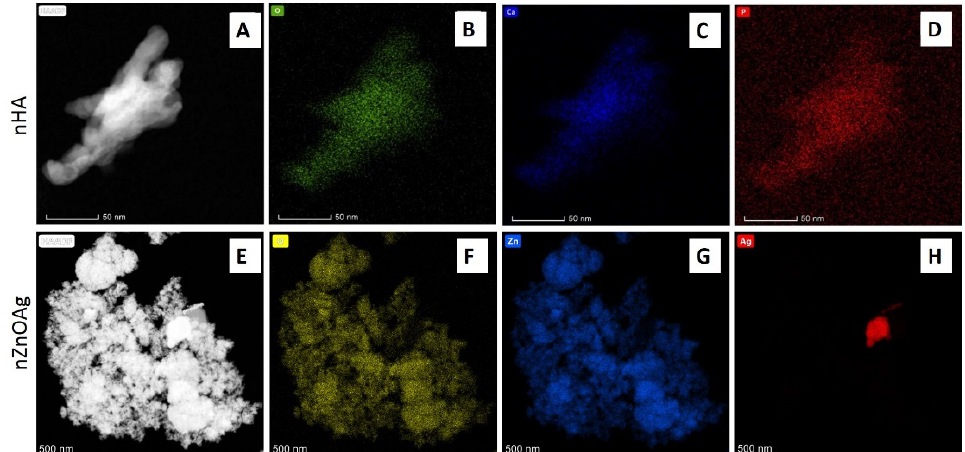
Figure 3. TEM images with energy ‐ dispersive X ‐ ray (EDX) mapping of different elements for nHA ( A – D ) and nZnO:Ag powders ( E – H ). For nHA TEM (top row), colors and complementary chemical elements on the map are as follows: (O—oxygen) green, (Ca—calcium) blue, (P—phosphorus) red. Respectively, for nZnO:Ag (bottom row), colors are: (O—oxygen) yellow, (Zn—zinc) blue and (Ag—silver) red.